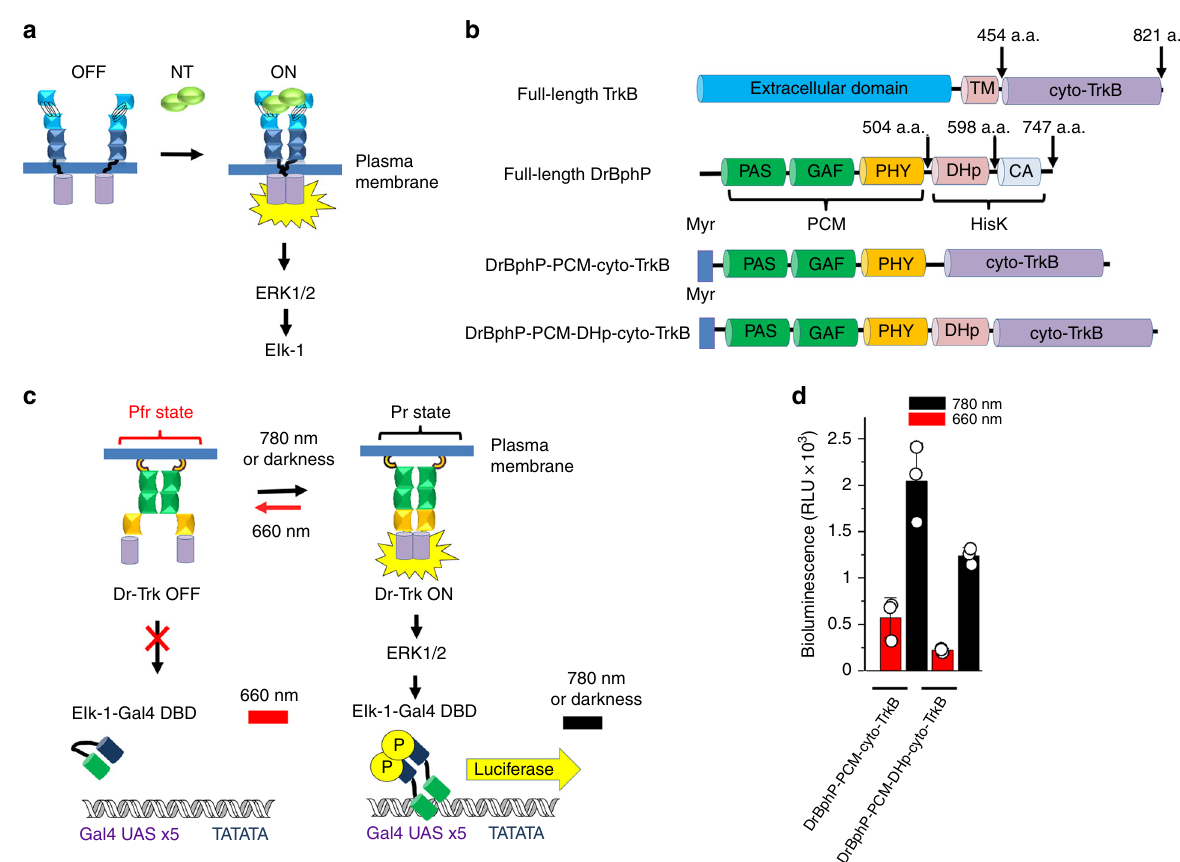
Fig. 1 Design and initial screening of DrBphP-PCM kinase fusions. a Activation of receptor tyrosine kinases (RTKs) by dimerization upon binding of a growth factor ligand. b Schematically depicted structures of the full-length TrkB, DrBphP, and developed for initial screening DrBphP-PCM-cyto-Trk fusion constructs. c Scheme of luciferase assay for kinase activity. The system consists of the reporter plasmid, pFR-Luc, where fi re fl y luciferase expression is controlled with the synthetic promoter, containing 5× tandem repeats of the yeast UAS GAL4 binding sites, and the transactivator plasmid pFA-Elk-1. In the transactivator plasmid, the activation domain of the Elk-1 is fused with the yeast GAL4 DNA binding domain (DBD). Under 780 nm light, DrBphP-PCM- cyto-Trk is active, which results in the activation of the MAPK/ERK pathway. The phosphorylated Elk-1-GAL4-DBD fusion dimerizes, binds to 5× UAS, and activates transcription of fi re fl y luciferase. Under 660 nm light, DrBphP-PCM-cyto-Trk is inactive, MAPK/ERK pathway (mitogen-activated protein kinase/ extracellular signal-regulated kinase) is inhibited, and luciferase expression is switched OFF. d Luciferase assay of initial DrBphP-PCM-cyto-Trk constructs in PC6-3 cells. PC6-3 cells were co-transfected with the pCMVd2-DrBphP-PCM-cyto-Trk, pFR-Luc, and pFA-Elk-1 plasmid mixture (1:100:5), and 6 h